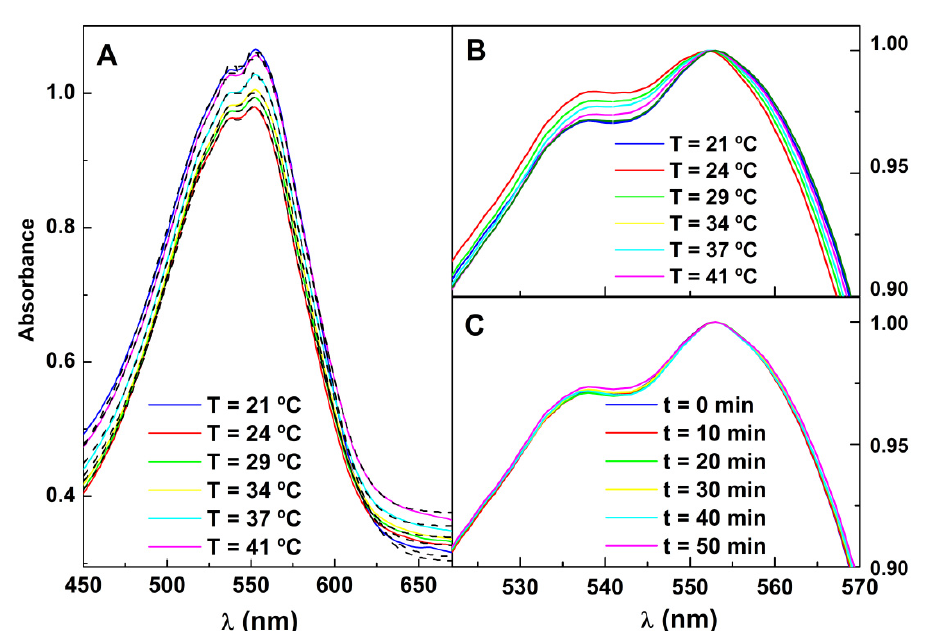
Figure 10. ( A ) Variation of absorption spectra of Nile Red in magnetoliposomes containing core/shell nanoparticles, at different temperatures and fitting to the model (dashed curves). ( B ) Expansion of the normalized spectra of Figure A in the maxima region. ( C ) Expansion of the nor- malized spectra in the maxima region at several times of irradiation.